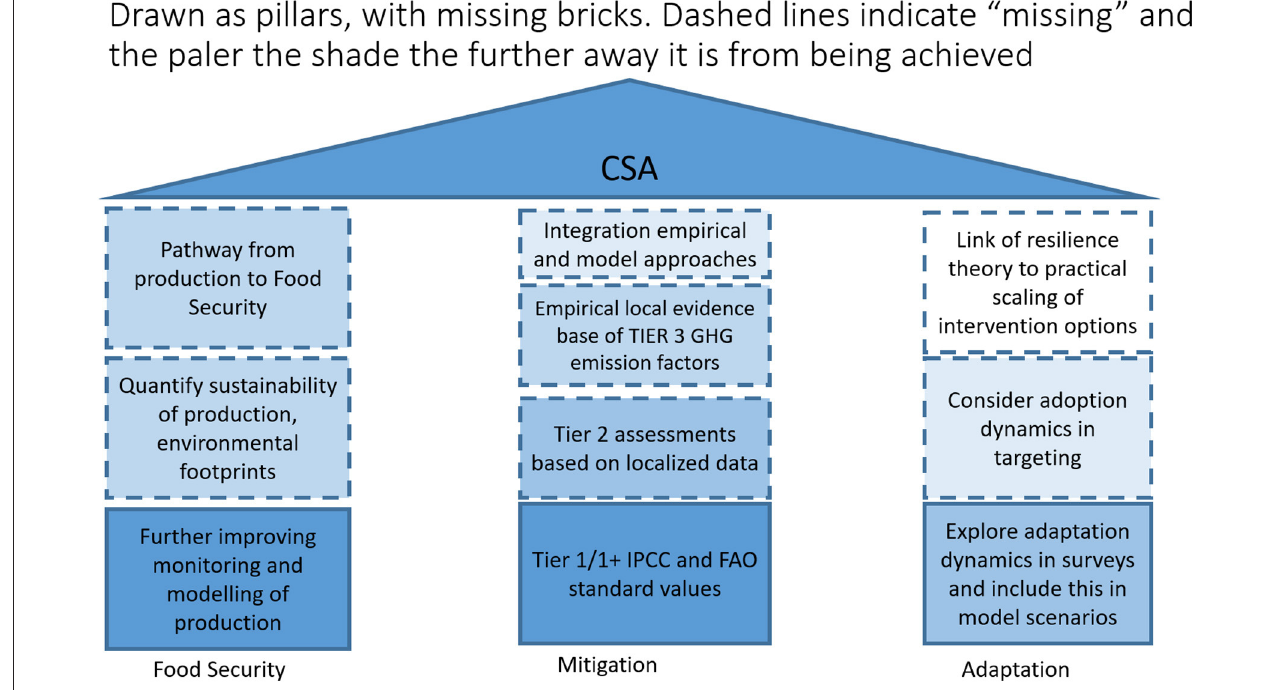
and climate. The latter are not completely functional yet for